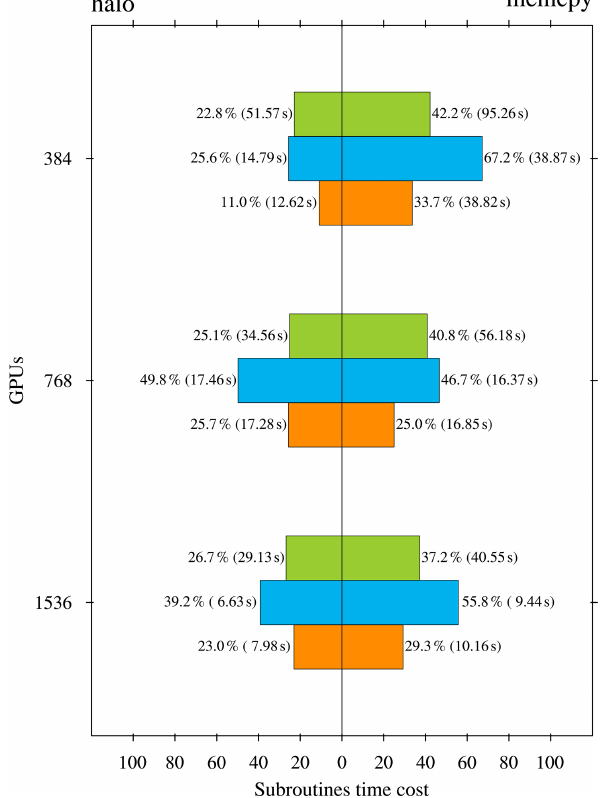
Figure 6. The ratio of the time cost of halo update and memory copy to the total time cost for the three subroutines, barotr (green), bclinc (blue), and tracer (orange), in the HIP version LICOM for three scales (unit: %). The numbers in the blankets are the time cost of the two processes (unit: